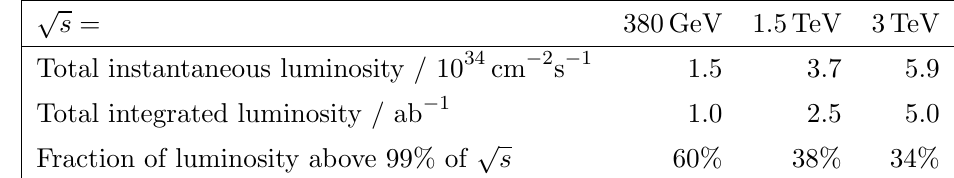
Table 1. Instantaneous and integrated luminosities for the baseline CLIC staging scenario, and fraction of the luminosity delivered above 99% of